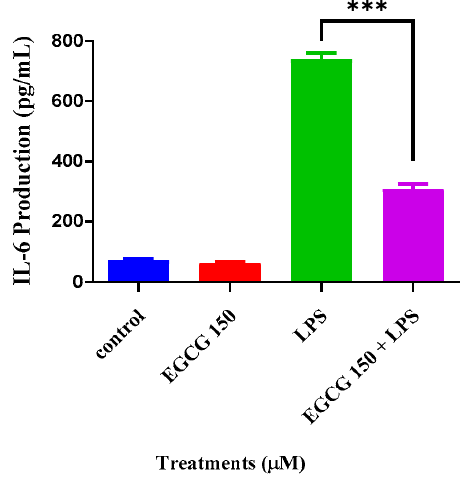
µ M coupled with 1 µ g/mL LPS reduce IL-6. LPS 1 µ g/mL Figure 3. EGCG concentrations at 150 µM coupled with 1 µg/mL LPS reduce IL-6. LPS 1 µg/mL Figure 3. EGCG concentrations at 150 showed a 50% increase in IL-6 production when compared to both controls (untreated cells and EGCG 150 µ M alone). EGCG 150 µ M with 1 µ g/mL LPS showed a 25% decrease in IL-6 production when compared with LPS (1 µ g/mL). Values represent the mean ± SD, *** p ≤ 0.001 vs. LPS.